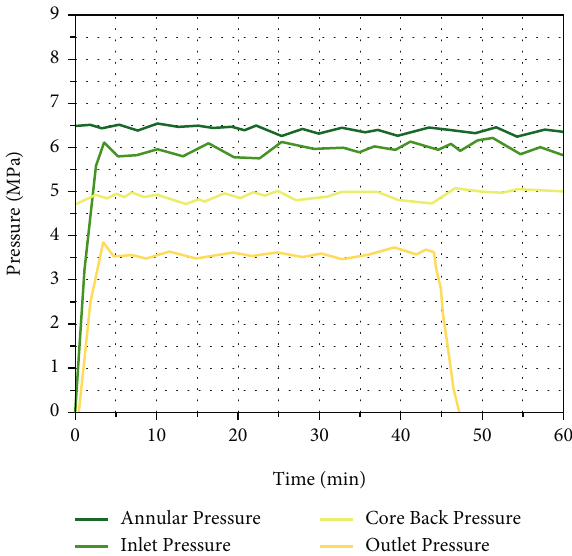
Figure 19: Experiment 12 plugging pressure change.